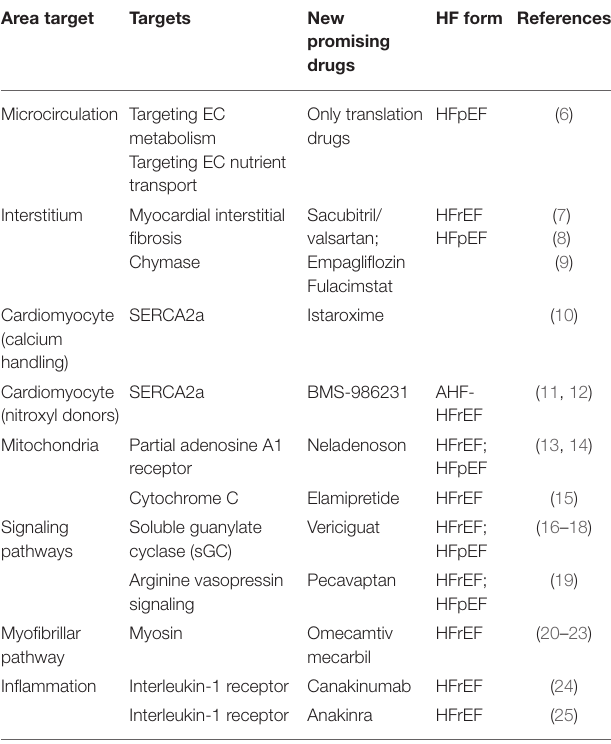
TABLE 1 | New possible pharmacological targets and promising drugs for the treatment of HF